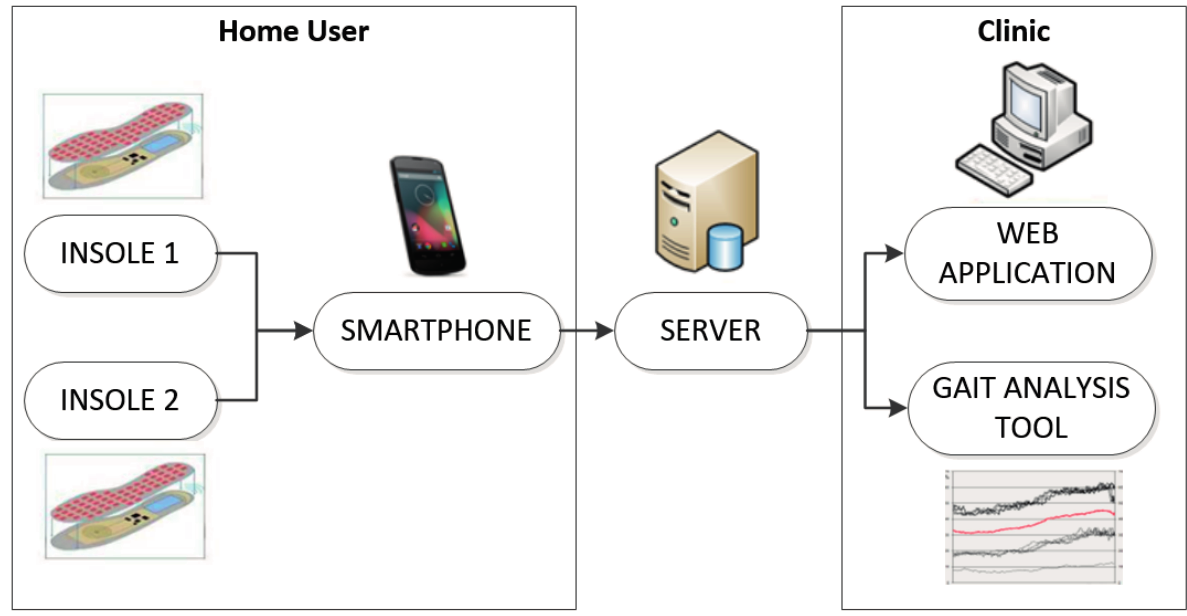
Figure 1. The WIISEL system